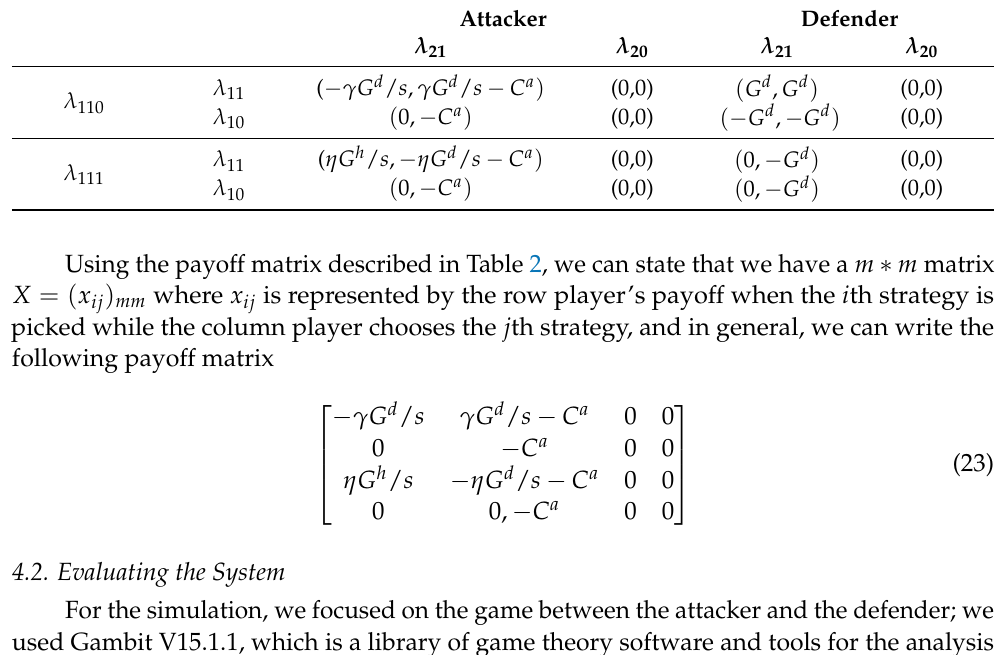
Table 2. Payoff matrix.